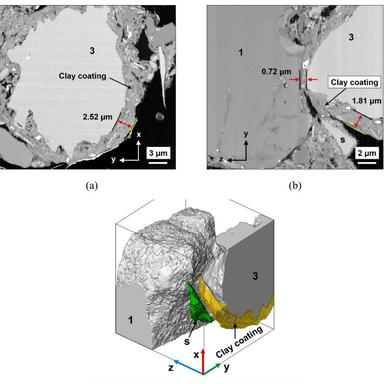
Clay coating. (a) Selected slice from the FIB-SEM images showing the cross-section of a coated silt particle (Particle 3). (b) Selected slice showing the contact between the coated particle and an adjacent uncoated silt particle (Particle 1). (c) 3D visualization of the spatial arrangement of the particles (including Particle 1 and a smaller particle denoted as 's') and the coating around Particle 3.